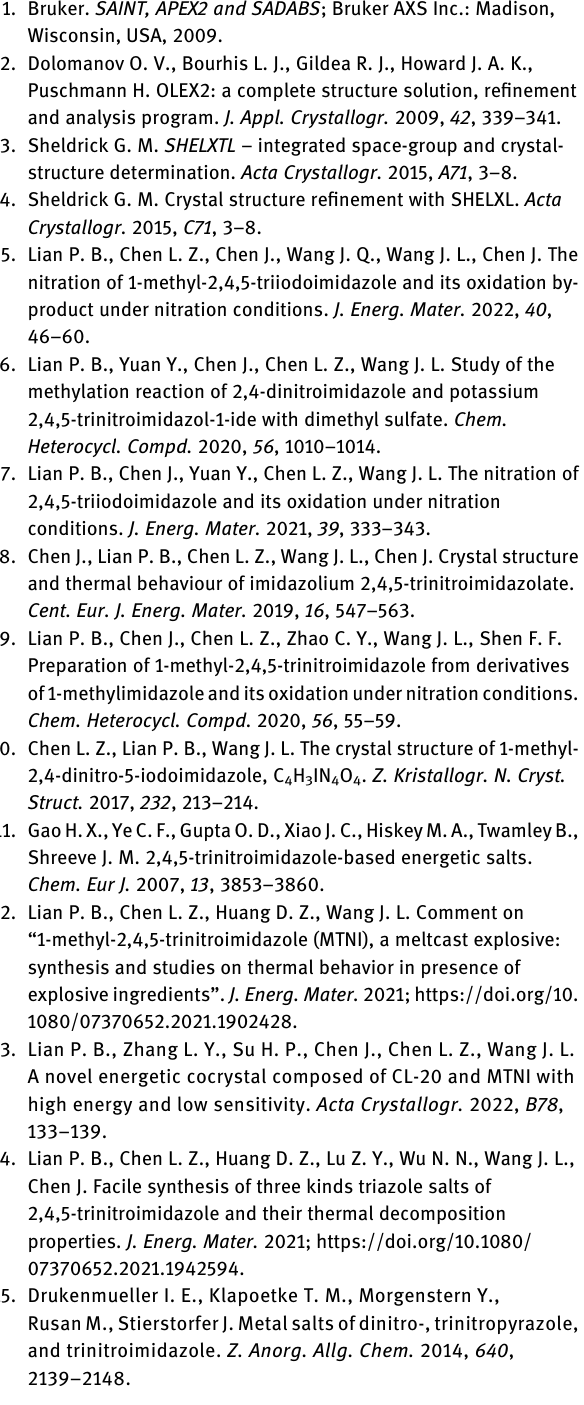
Table  : Fractional atomic coordinates and isotropic or equivalent isotropic displacement parameters (Å 